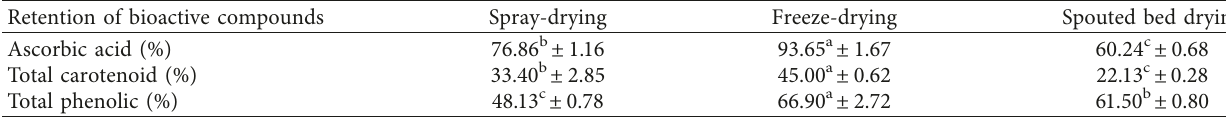
Table 4: Bioactive compounds of acerola-ceriguela mixed pulps obtained by different drying methods.